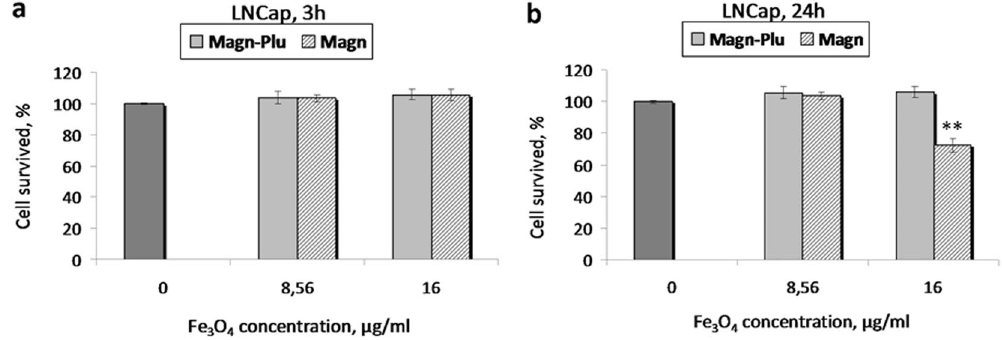
Figure 7. Histograms of LNCaP cell viability after incubation with two types of superparamagnetic iron oxide NPs for 3 h ( a ) and 24 h ( b ). MTS assay. Results are shown as means ± SD. ** P < 0.01 (one-way ANOVA). comparing to control